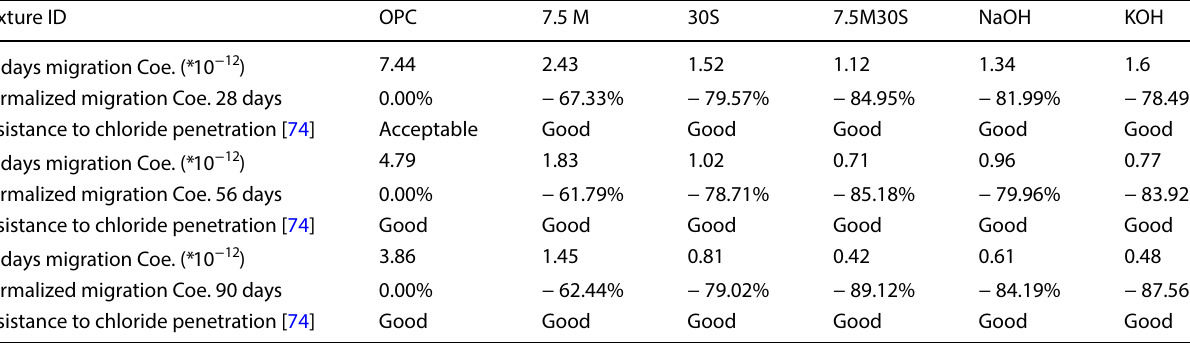
Table 8 Migration coefficients derived from RCMT at different ages up to 90 days Mixture ID